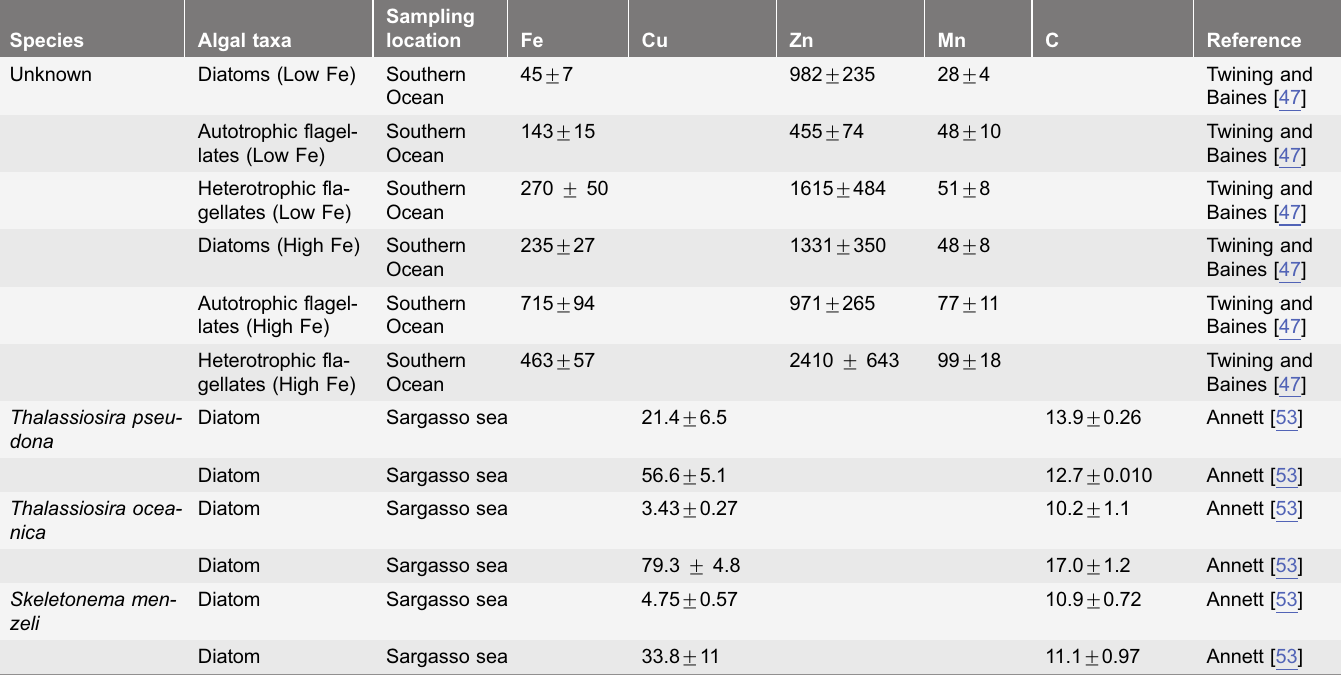
Table 4. Trace element concentrations (mean ¡ standard deviation) in cellular phytoplankton ( m mol L 2 1 ).